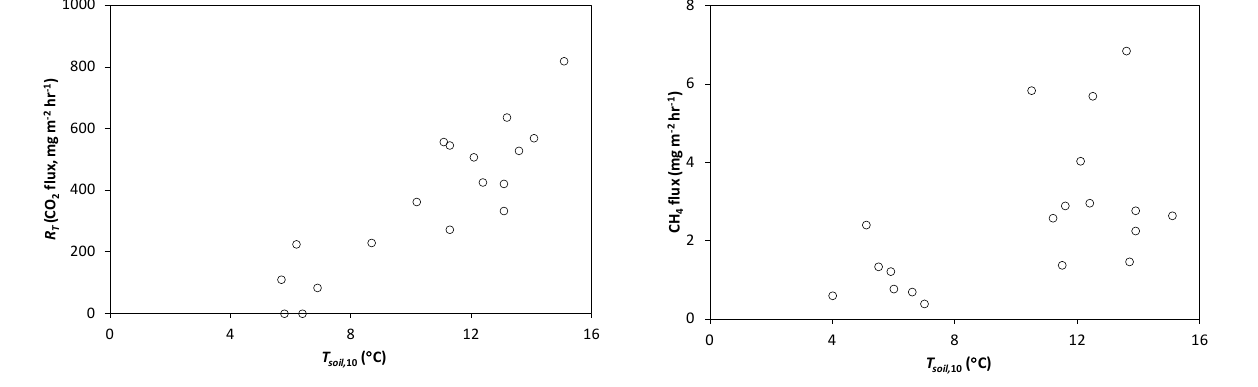
Figure 4. Variation in ecosystem respiration ( R with soil temperature at a depth of 10 cm for one of the collars at the North Wales blanket peatland site.